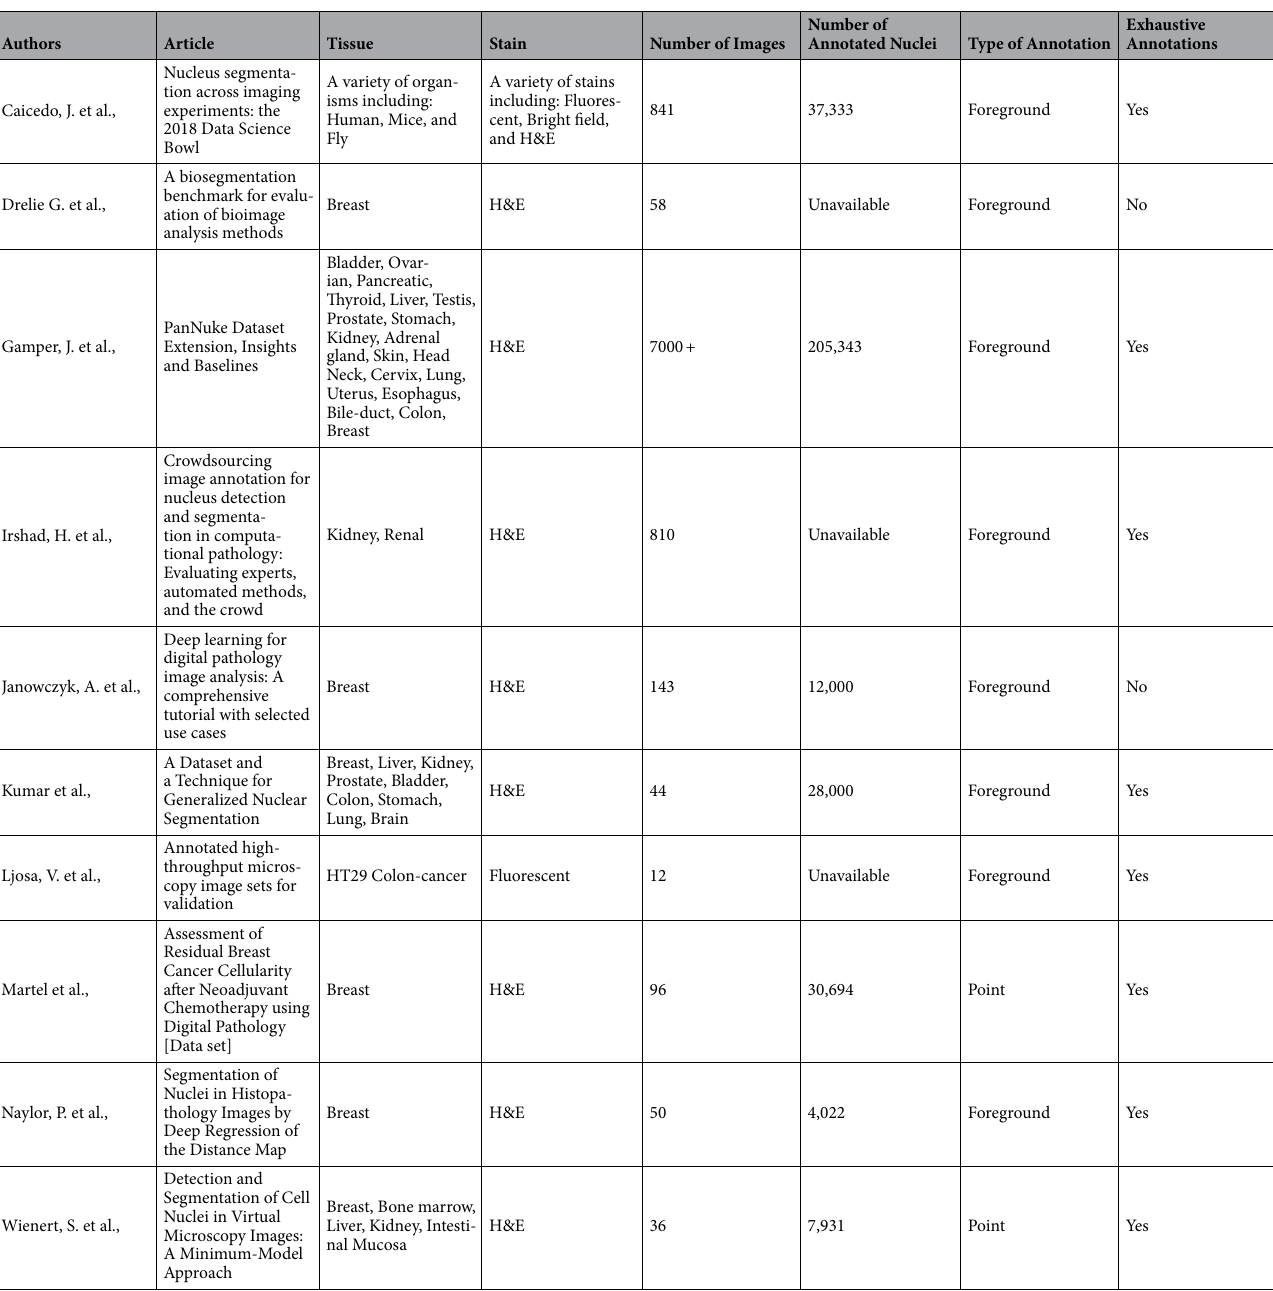
Table 1. Open-source histopathological datasets. The datasets were annotated in two ways, 1) foreground – borders of the nuclei were outlined, 2) point – nuclei were identified with a single mark. Exhaustive annotations indicate that all nuclei within the images had been marked or